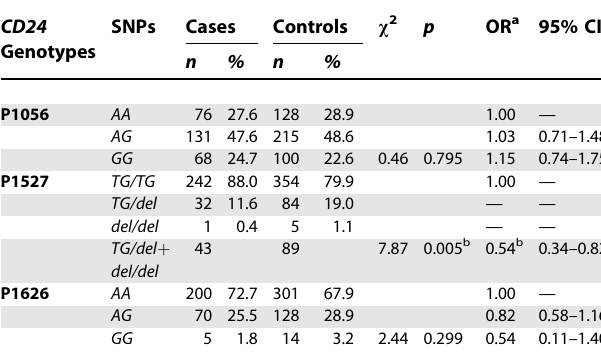
Table 2. CD24 Genotype Frequencies for All MS Participants and Controls CD24 Genotypes